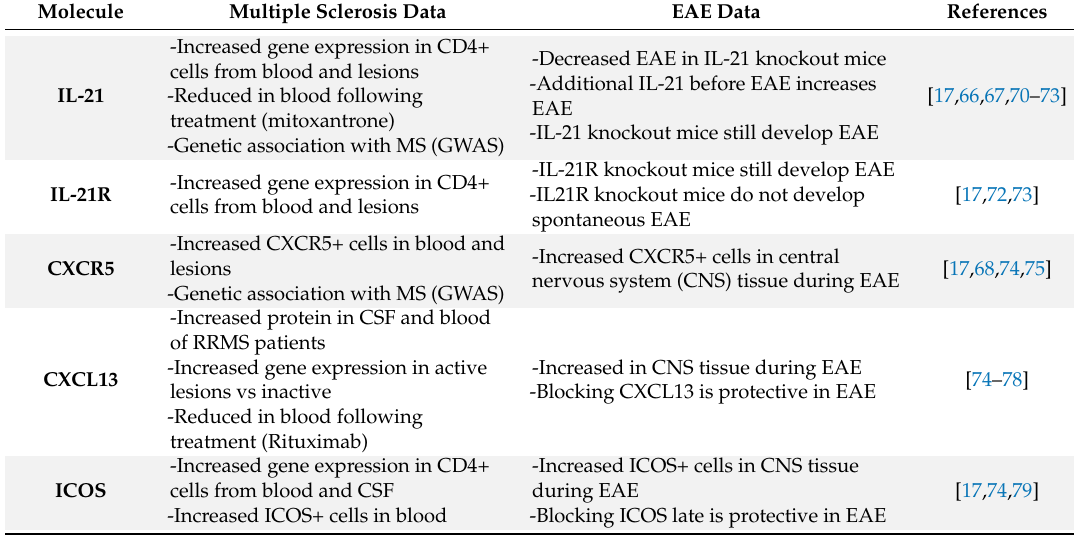
Table 1. Follicular T helper cell (TFH) molecules in multiple sclerosis (MS) and experimental autoimmune encephalomyelitis